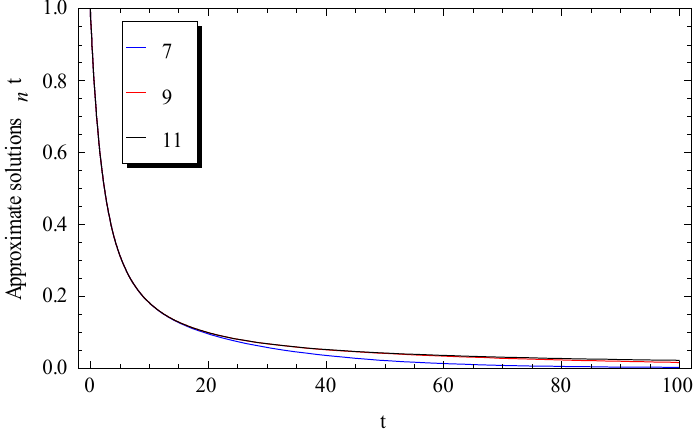
Figure 2. Convergence of the Adomian approximate solutions at λ = 1 and q = 1.6.